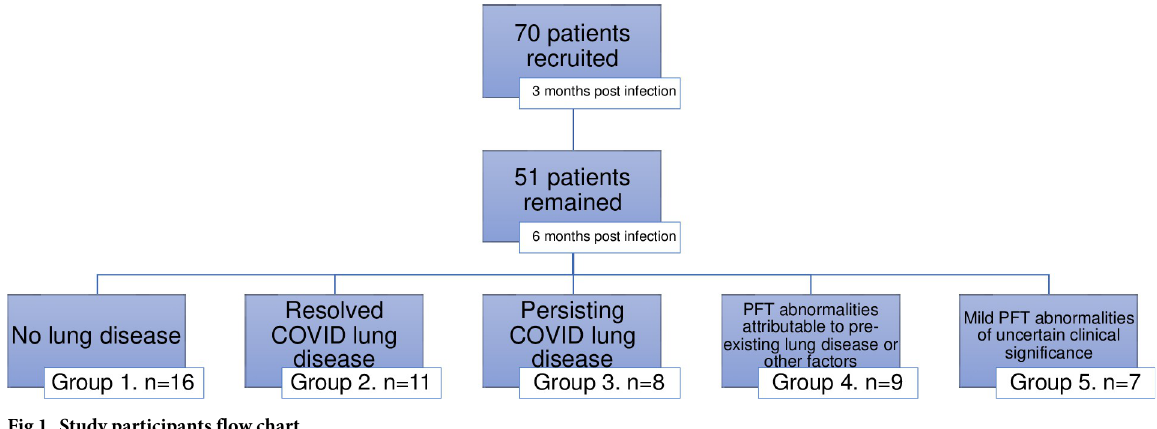
Fig 1. Study participants flow